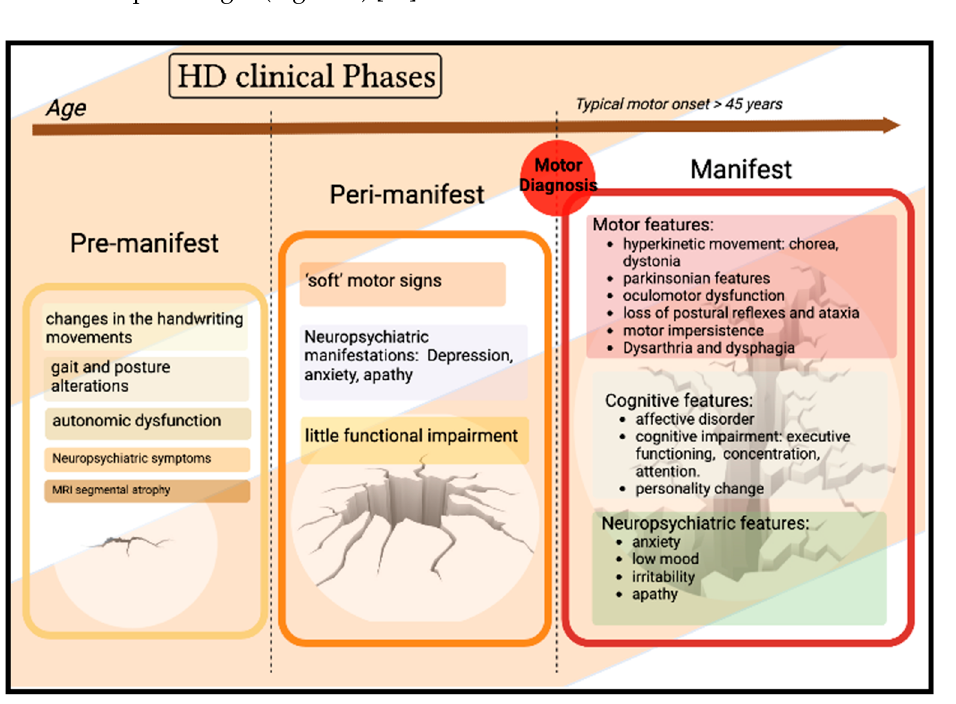
Figure 1. Clinical phases of Huntington’s disease